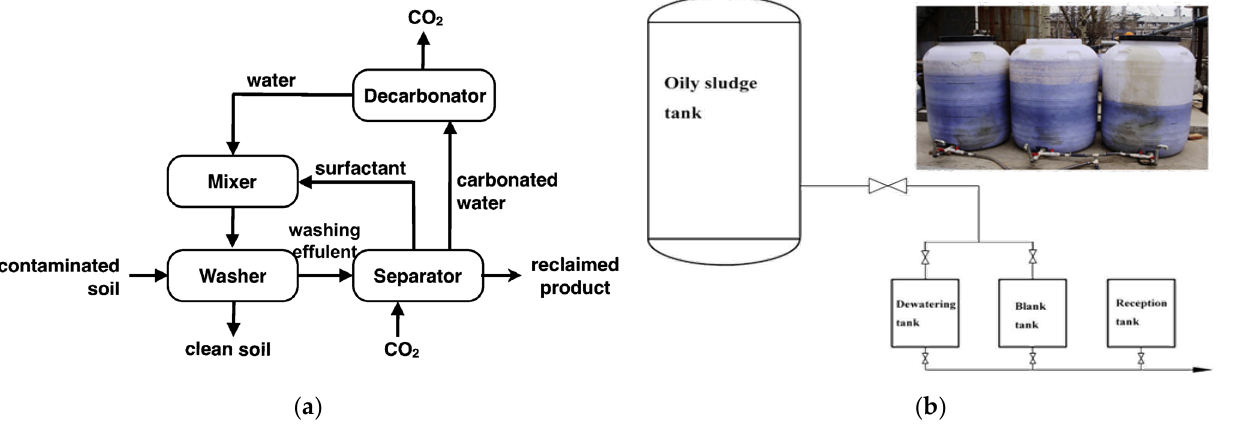
Figure 15. ( a ) A proposed scheme of soil washing using CO 2 switchable anionic surfactants. Reproduced with permission from Ceschia et al., 2014 (ref. [195]). Copyright of The Royal Society of Chemistry 2014. ( b ) The experimental setup of pilot scale dewatering of oil sludge. Reproduced with permission of Long et al., 2013 (ref. [196]). Copyright 2013 Elsevier Ltd.